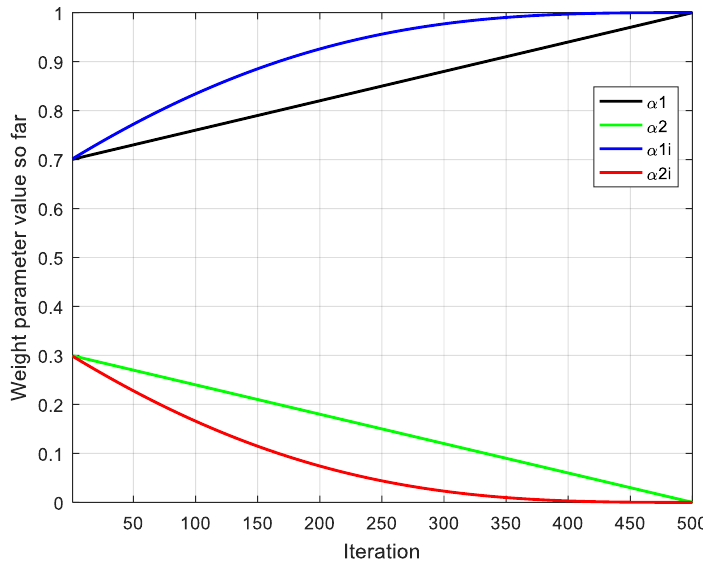
Figure 4. Comparison of weight coefficients a1 and a2 before and after improvement.